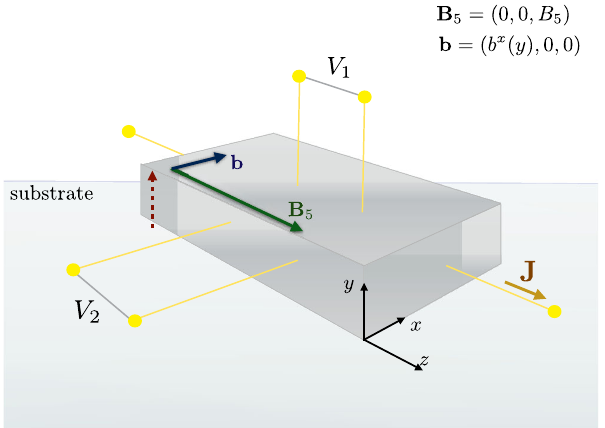
FIG. 8. A schematic point-contact transport setup to measure the current J (orange arrow) to determine the strain-dependent conductivity σ ∼ B 2 5 predicted in this work. Strain is induced by the substrate with a small lattice mismatch that relaxes along the y direction (red dashed arrow). If the Weyl node separation is b ∥ ˆ x (blue arrow), then B 5 ∥ ˆ z (green arrow). Contacts V 1 ( V 2 ) probe a surface with (without) Fermi arcs, resulting in an anisotropic contribution to the